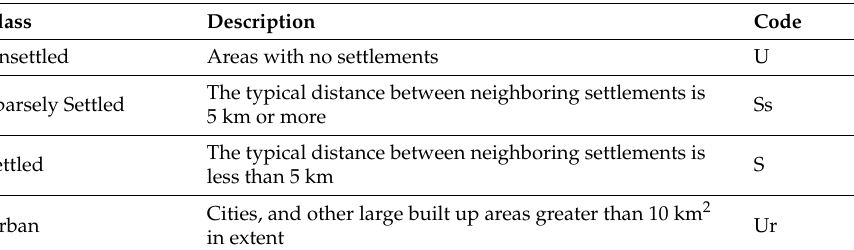
Table 4. Settlement pattern, description, and the code of each class.